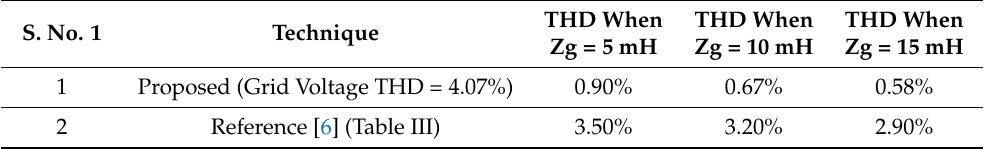
Table 3. THD of i g (proposed system vs. [6]). S. No.